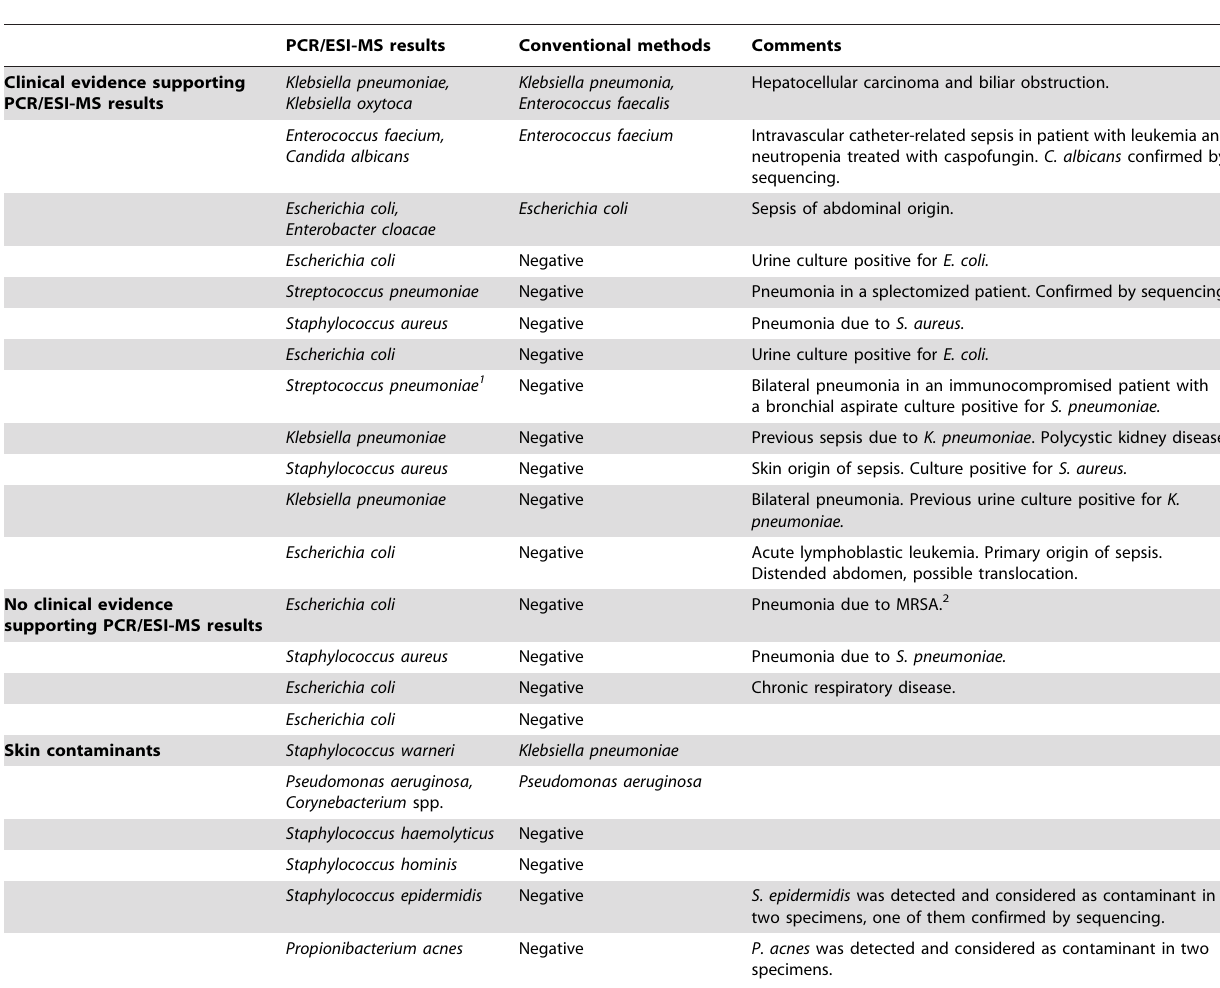
Table 6. Discrepancies found between the PCR/ESI-MS in whole blood and conventional